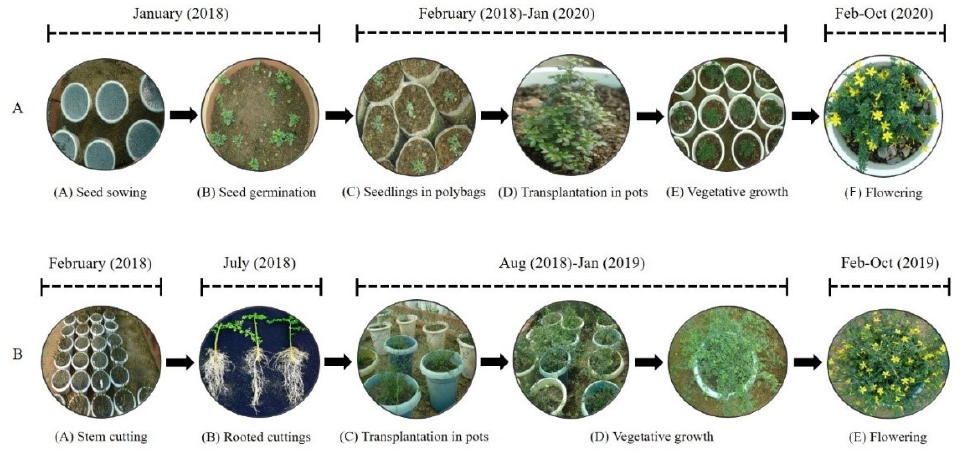
Figure 2. Vegetative and flowering stages during propagation of Jasminum parkeri : ( A )—through seed; ( B )—through stem cuttings.